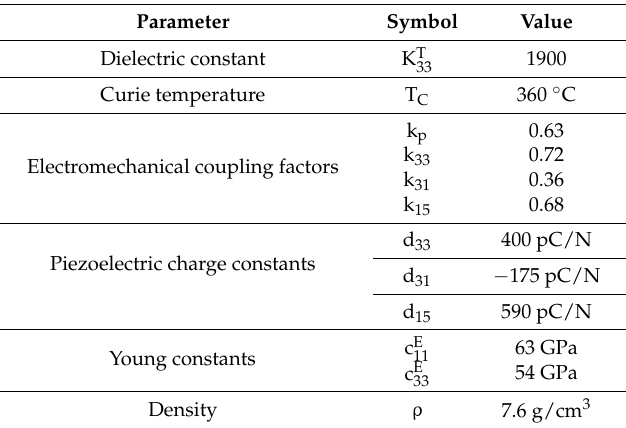
Table 1. Properties of PZT